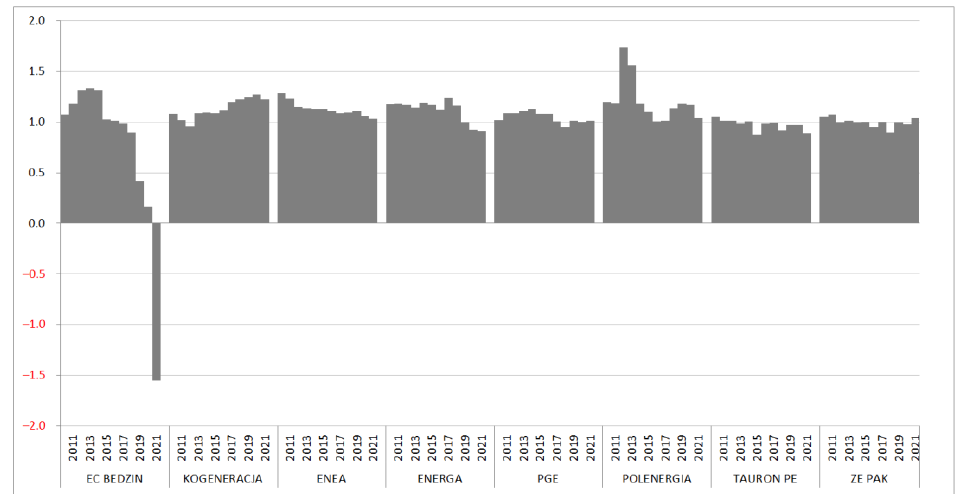
Figure 10. Coverage of fixed assets with fixed capital in analyzed energy companies. Source: own elaboration.